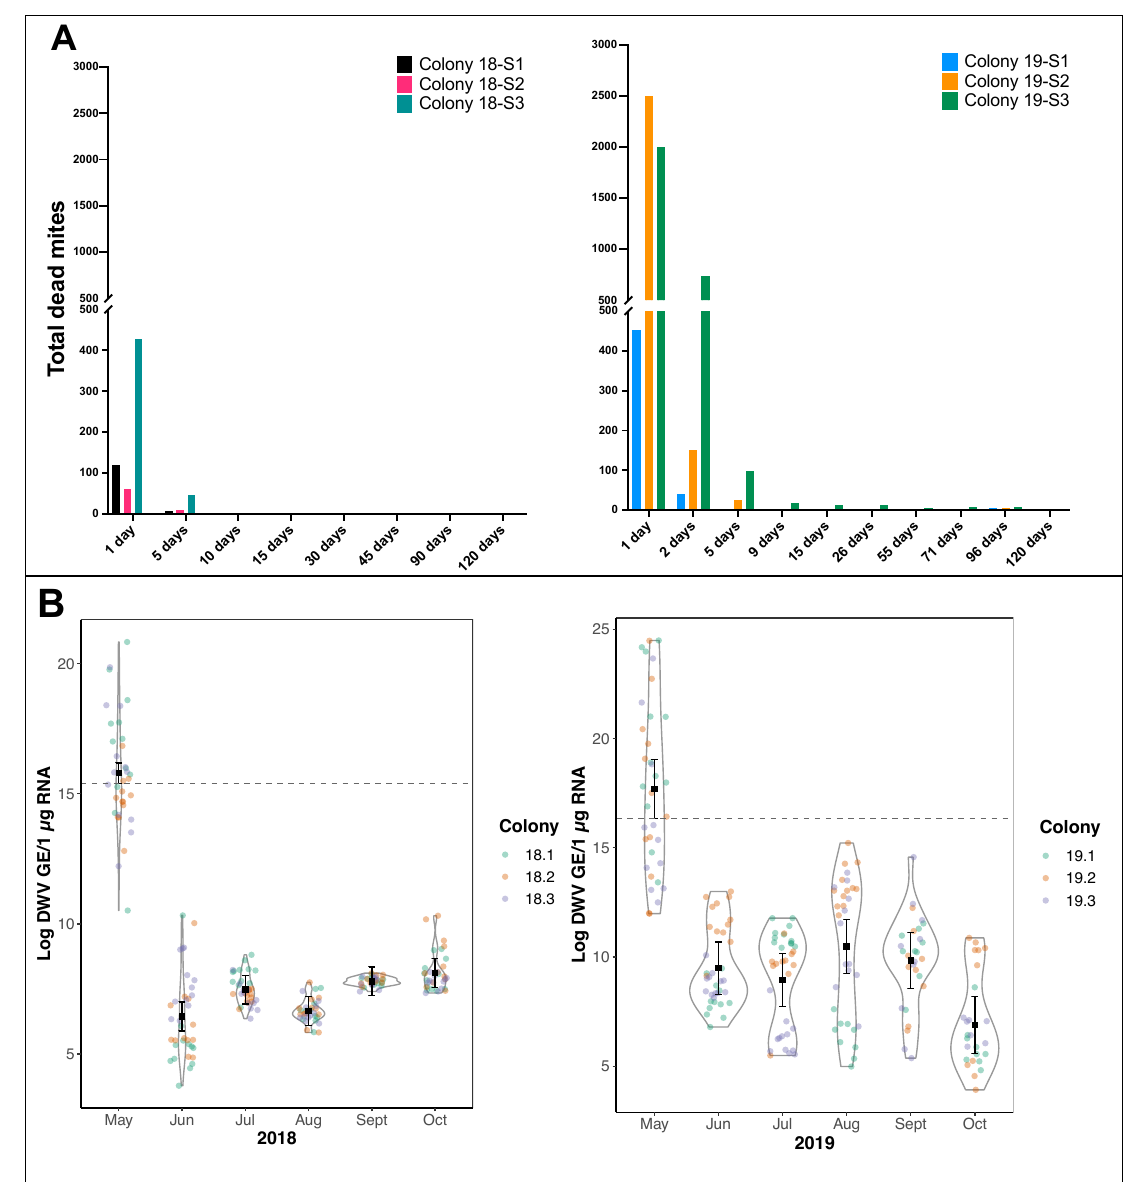
Figure 1. Varroa drop post-treatment and log DWV levels in emerging brood before and after shook swarm and Apivar treatments. The shook swarm and Apivar treatment was applied to the colonies after the first timepoint. A. Varroa drop was counted every few days in 2018 (left) and 2019 (right) after the shook swarm and Apivar application. Additional time points where no Varroa was observed omitted for simplicity B. A violin plot showing the log DWV load in workers as measured each month after treatment. Coloured circles represent individual honey bee samples from each colony (n=12). The black square and represents the predicted mean from the mixed-effects model for each time point with corresponding 95% confidence intervals around the mean. Estimates and 95% confidence intervals below the dashed line indicate they are below the lower 95% confidence interval from the pre-treatment.